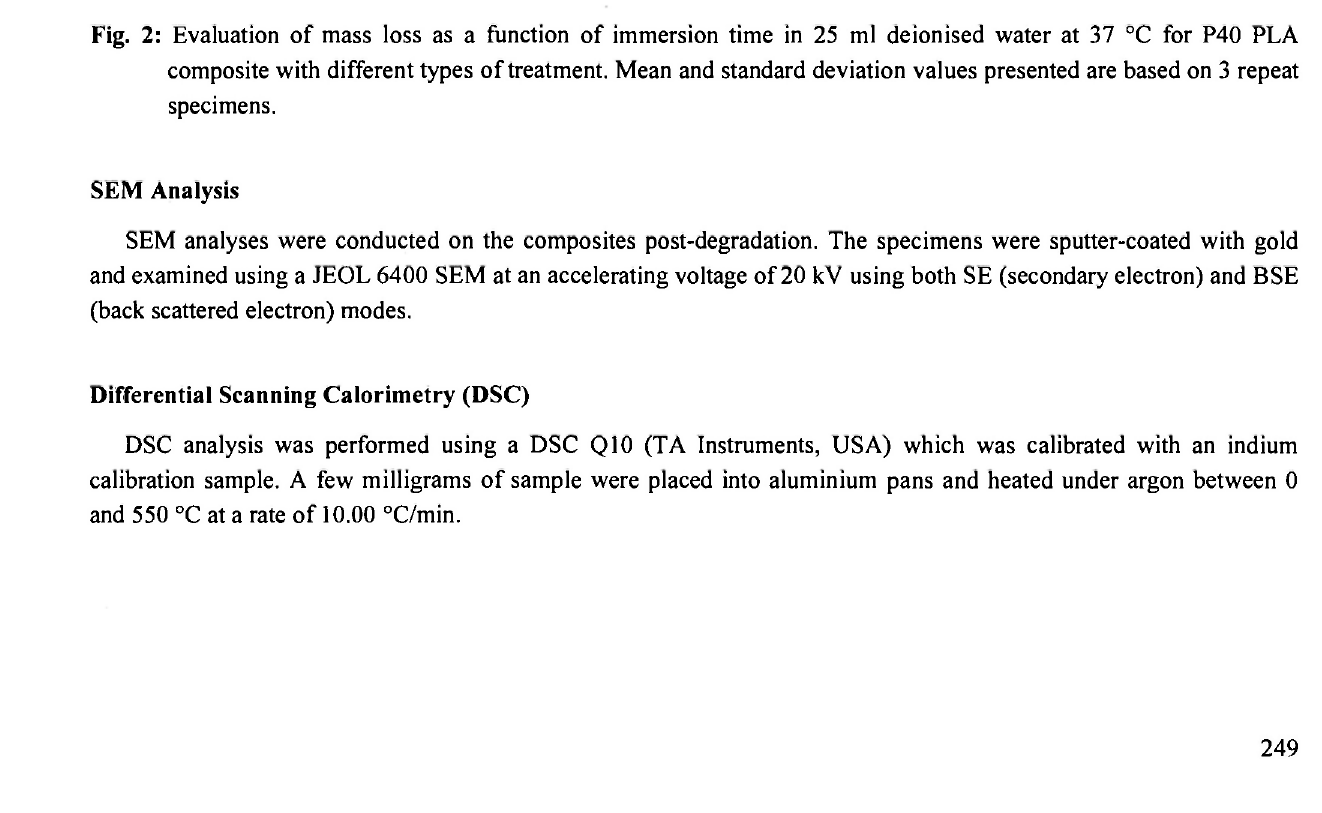
Fig. 2: Evaluation of mass loss as a function of immersion time in 25 ml deionised water at 37 °C for P40 PLA composite with different types of treatment. Mean and standard deviation values presented are based on 3 repeat